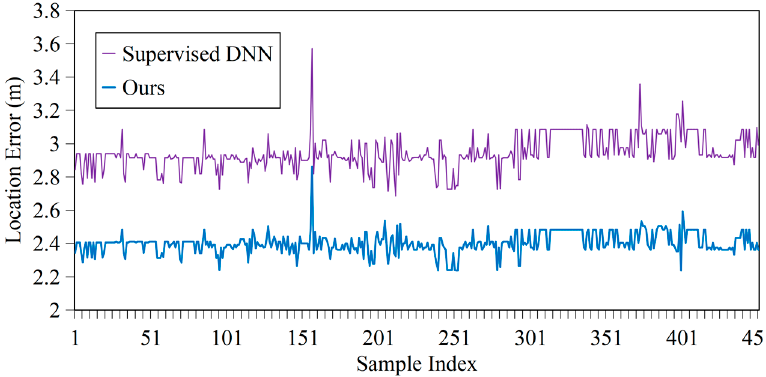
Figure 15. Location error curves when GNSS is denied in Scenario 2. Table 2. Location error parameters in GNSS denied